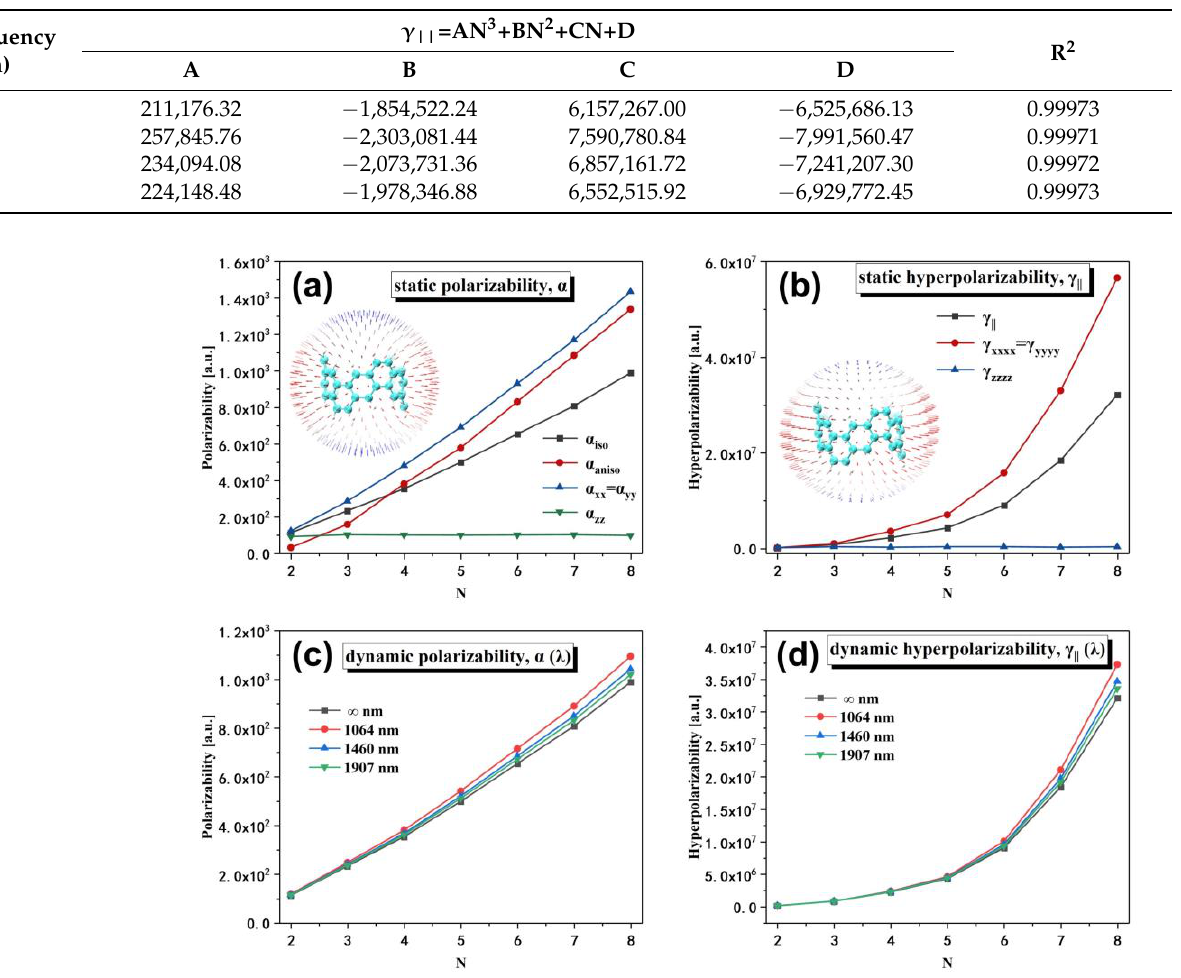
Table 2. The extrapolation formula of the second hyperpolarizability of [2N,2N]CNB under differ- ent external fields.